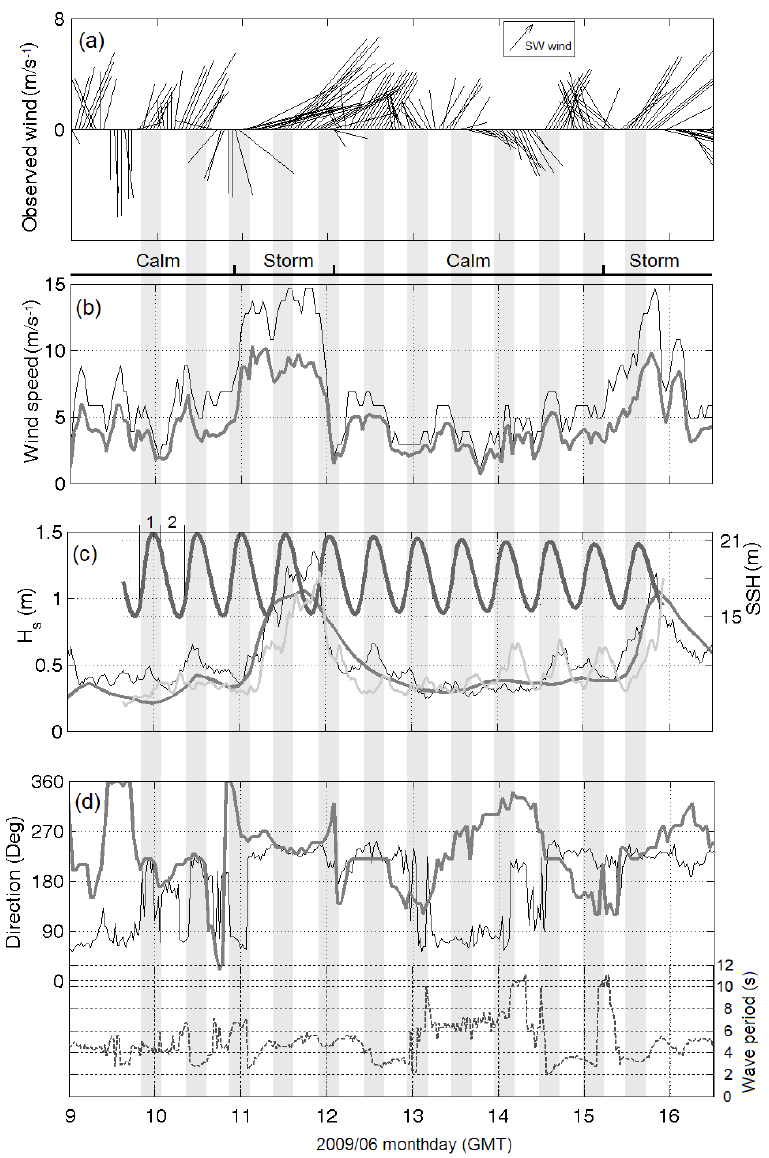
Fig. 2. Time series of (a) wind stick diagram, (b) wind gusts (black line) and averaged wind speed (grey line) (c) , H S observed by ADCP (grey line) and CEFAS buoy (black thin line), (d) wave (black line) and wind (grey line) directions, and wave period (dashed line) observed by CEFAS buoy. Two distinct storm events and calm periods, identified based on the wind speed and wave height records are annotated above the panel (b) . In the panel (c) , flood and ebb phases are indicated on the SSH line by 1 and 2, respectively and flood periods are shaded.